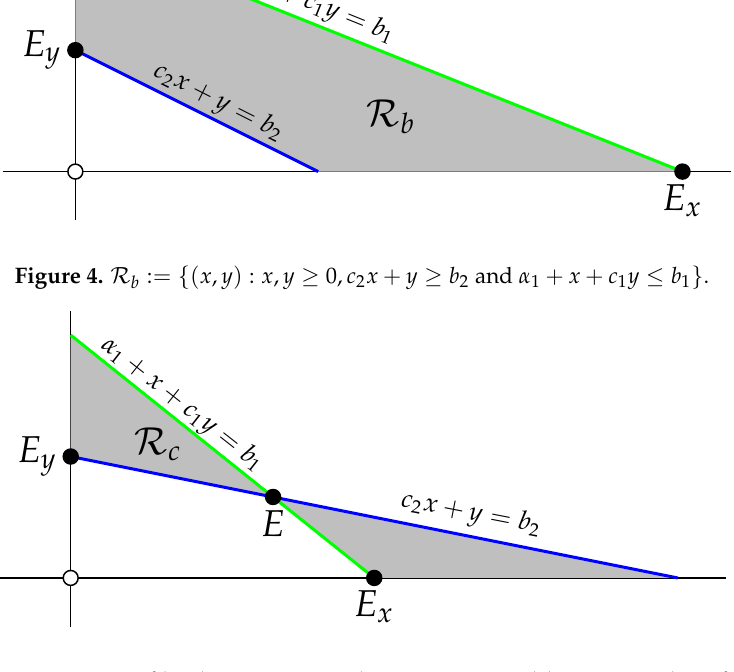
Figure 5. R c : = { ( x , y ) : x , y ≥ 0 and ( x + c 1 y + α 1 − b 1 )( c 2 x + y − b 2 ) ≤ 0 }